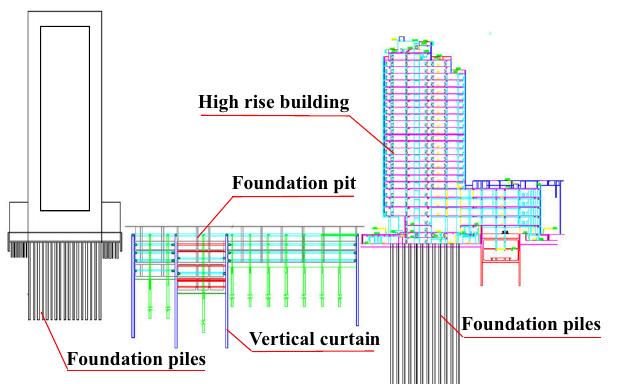
Figure 1. Curtain cutoff, pumping and recharging measures to control groundwater level for